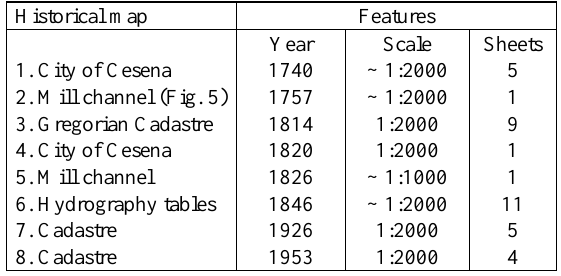
Table 7. Historical maps inherent the studied area; year, scale